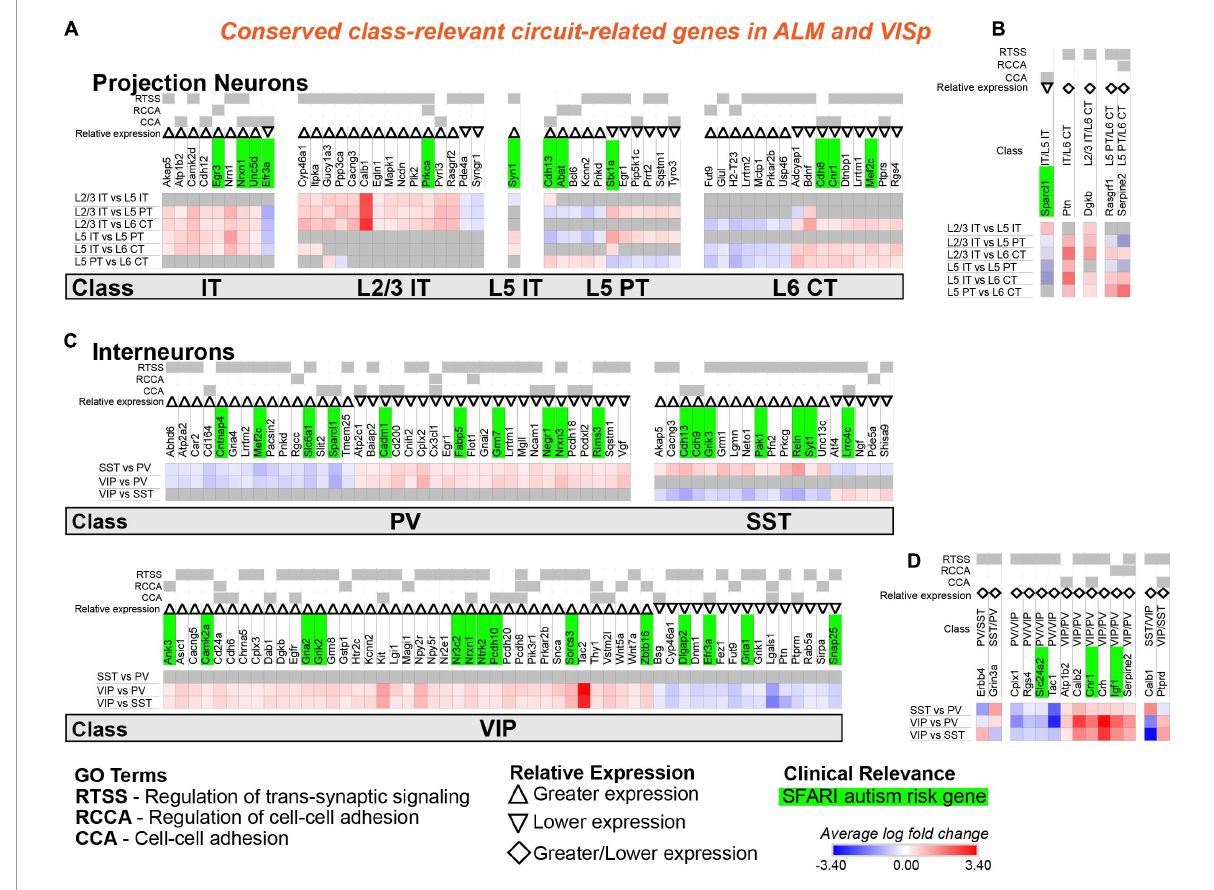
FIGURE7 Circuit-related genes that are relevant to the same neuronal classes in ALM and VISp. Each row (e.g., L2/3 IT vs. L5 IT) presents the results of differential expression tests between neuronal classes. Differential expression results are always relative to the first neuronal class in a comparison (e.g., L2/3 IT in ‘L2/3 IT vs. L5 IT’). Gray indicates no significance in differential expression. Shades of red and blue indicate the log fold change of average expression for tests that were statistically significant. Up and down arrows denote whether expression is higher or lower relative to the other classes. The diamond symbol in (B,D) indicates that a gene is relevant to two different classes: it is equivalent to an up arrow for the first gene and a down arrow for the second. For example, in (D) the PV class has greater expression of Erbb4 relative to both VIP and SST classes, and the SST class has lower expression relative to both VIP and PV classes. (A) Circuit-related genes relevant to single classes of excitatory projection neurons. We created the new class “IT” for genes that were relevant to both L2/3 IT and L5 IT classes. (B) Circuit-related genes relevant to multiple classes of excitatory projection neurons. (C) Circuit-related genes relevant to single classes of inhibitory interneurons. (D) Circuit-related genes relevant to multiple classes of inhibitory interneurons. CCA = cell-cell adhesion; RCCA = regulation of cell-cell adhesion; RTSS = regulation of trans-synaptic